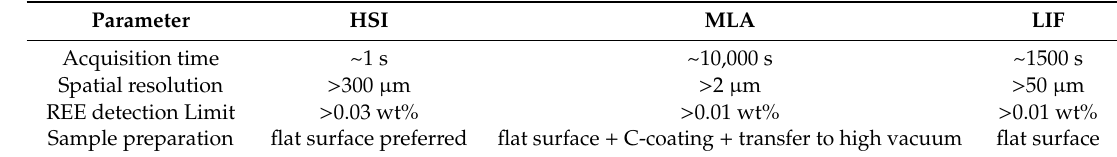
Table 2. Comparison of employed 2D imaging techniques for geological samples. The acquisition time is given for the measurements of 4 × 2 cm 2 rock pieces in steps of 500 µ m (HSI + LIF) and 4 µ m (MLA), respectively. Detection limits for HSI were taken from [36,43], for MLA calculated from the quantitative analysis, and for LIF from complementary electron microprobe